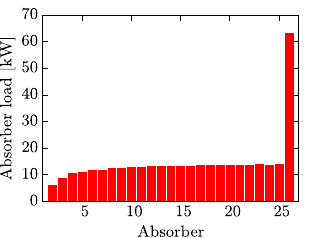
FIG. 17. Heat conductivity of OFHC copper versus tempera- ture. Data from